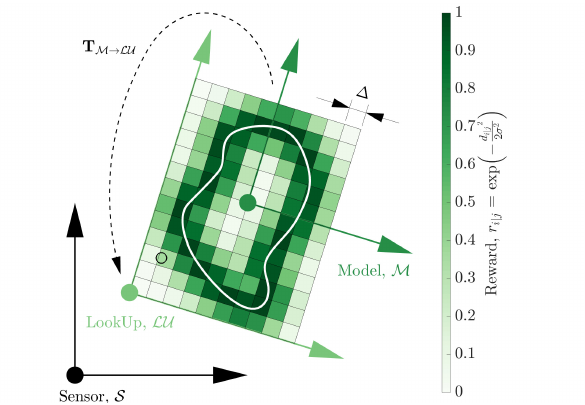
, is selected such that a bounding region of pixels (or voxels in 3D) around Figure 5. A lookup frame, the model can be described by precalculated distances to the model surface. The pixels are discretised at LU a resolution of ∆ , as shown. The lookup frame is rigidly attached to the model coordinate frame (with transform T M→LU ) such that it moves with the hypotheses of the model pose. Algorithm 1 describes the generation of the lookup table. Algorithm 1: Lookup table generation